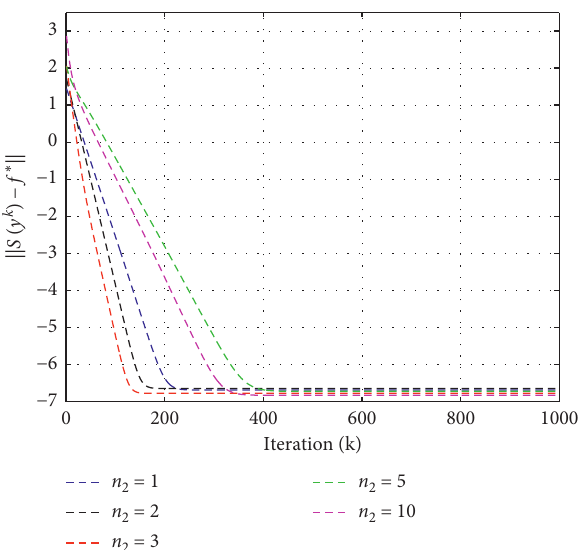
Figure 5: Convergence of S ( y k ) illustrated with different di- mensions of complicating variable y . The figure shows that S ( y k ) converges almost to f ∗ , the optimal value of the primal problem (39) regardless of the dimension of y .